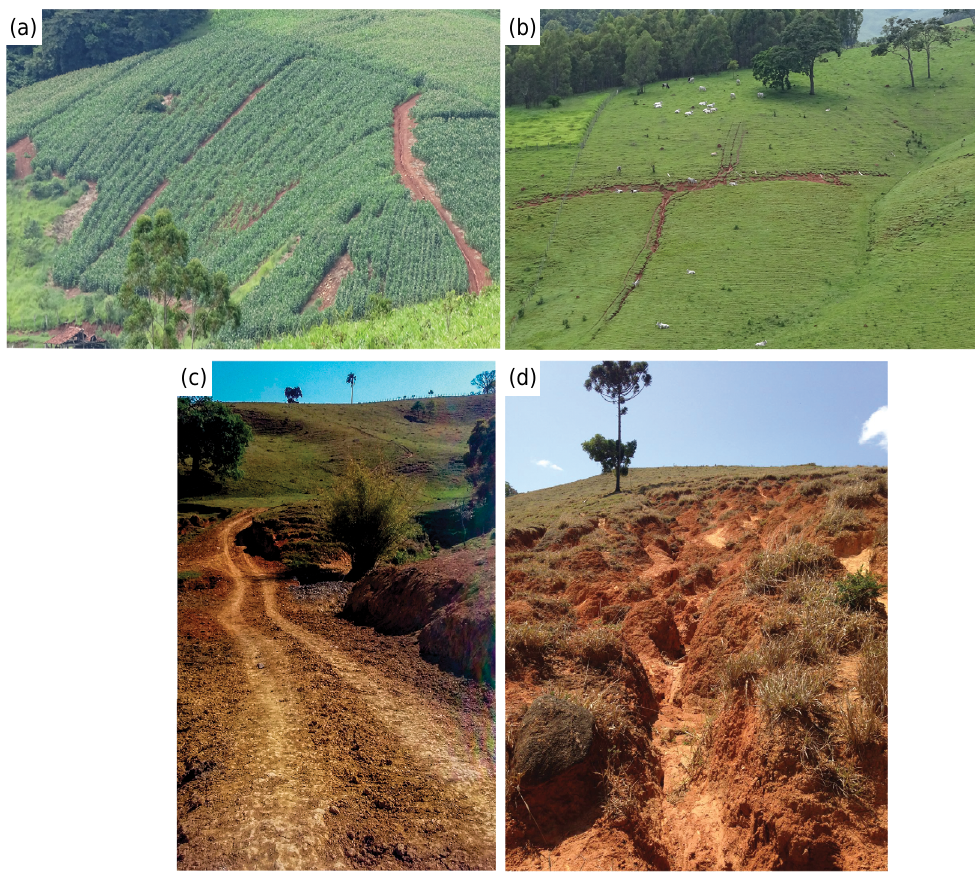
Figure 4. Downslope cultivated cornfield (a), eroded cattle trails (b), steep rural roads with no conservation planning (c), deep rills, and small gullies found at degraded pastures (d) in the Posses catchment,